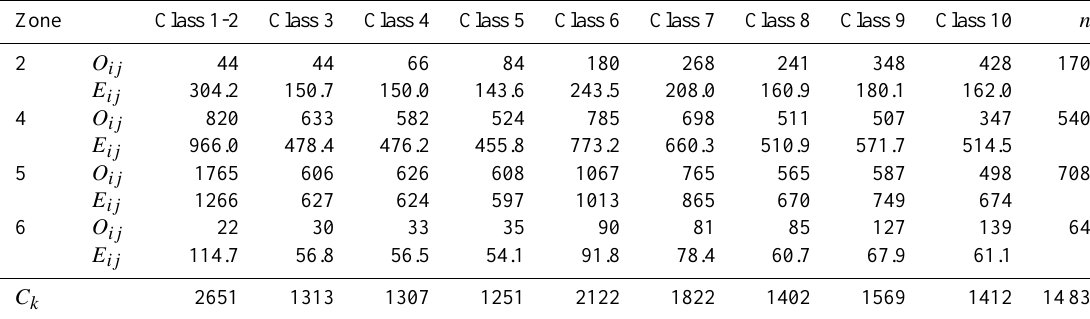
Table 11. Summary of results applying the chi-square test for size.